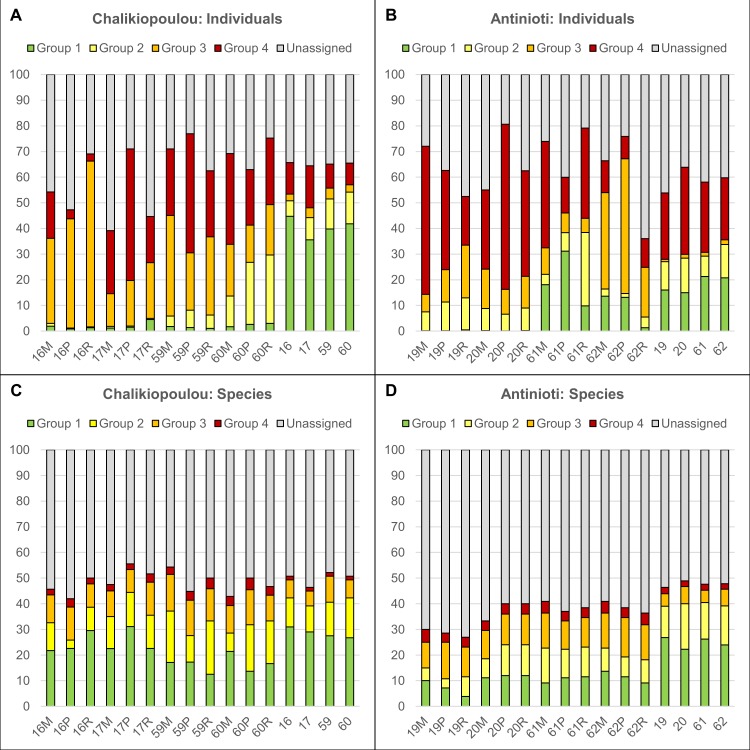
Distribution of relative abundances of foraminifera belonging to four ecological groups based on Foram-AMBI within in situ and experimental assemblages.See text for details on group assignments. (A) Individuals from Chalikiopoulou lagoon. (B) Individuals from Antinioti lagoon. (C) Species from Chalikiopoulou lagoon. (D) Species from Chalikiopoulou lagoon.